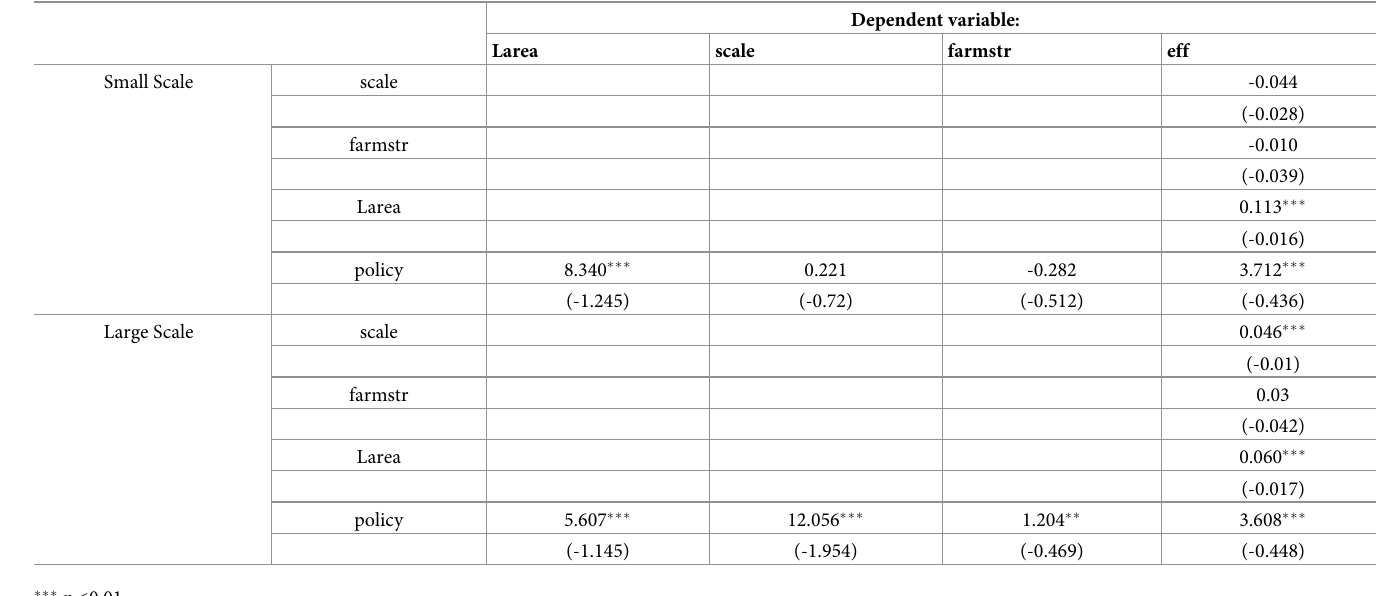
Table 8. Estimation results of parallel mediating effects model of the effect of GECP on the efficiency of breeding technology: Based on different feeding